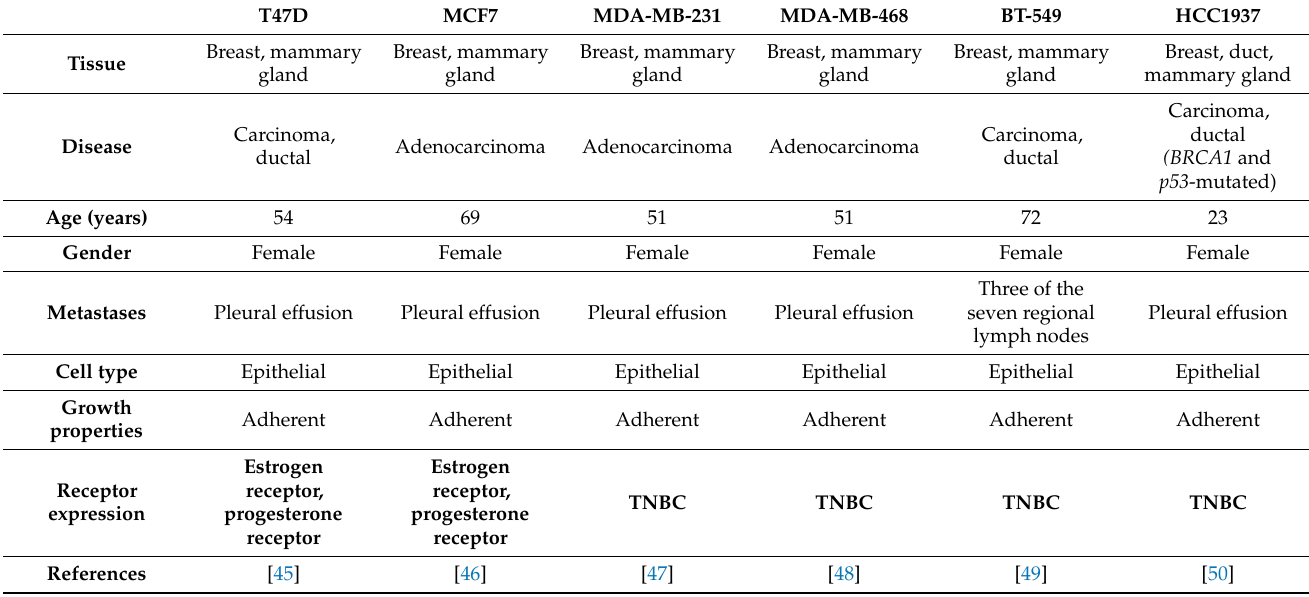
Table 1. The detailed characteristics of BC cell lines used in the